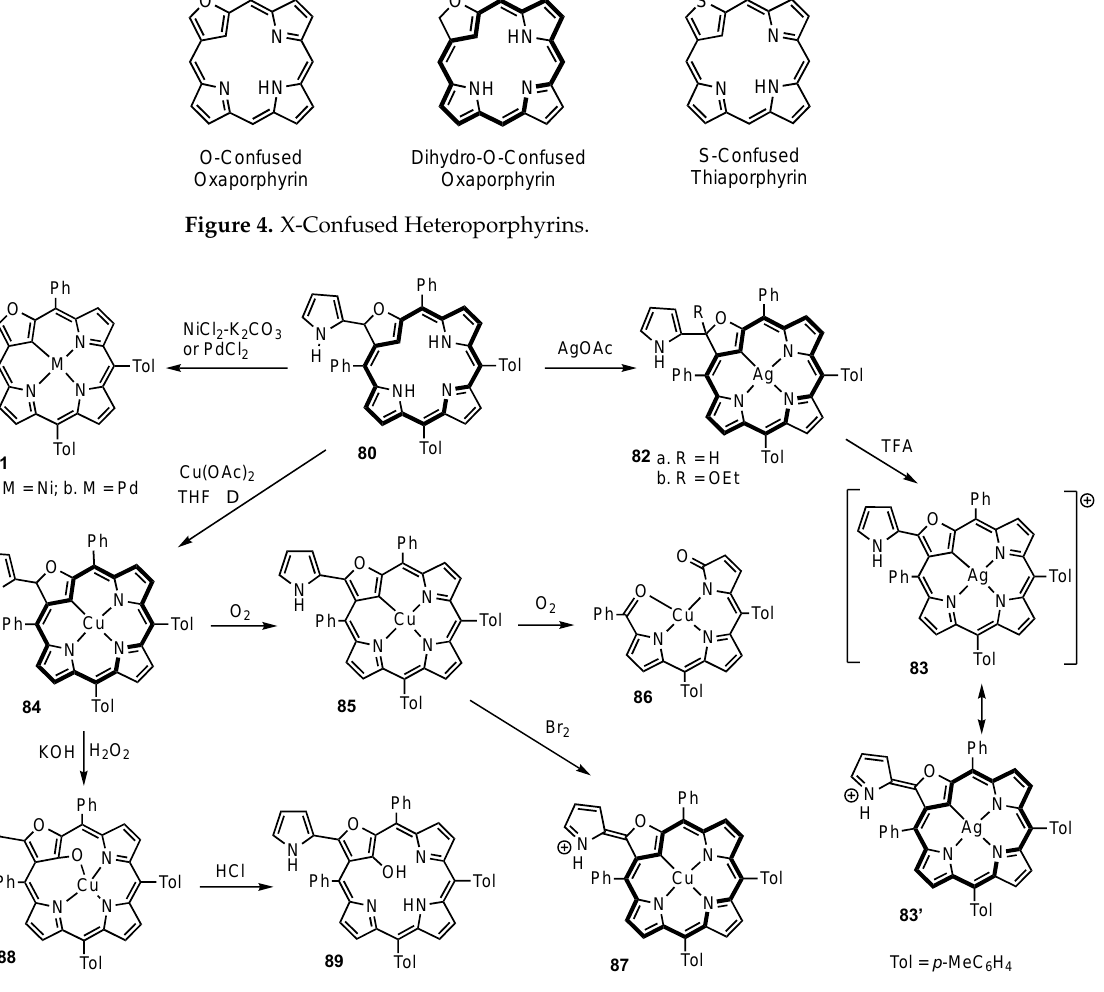
Scheme 19. Metal complexes of pyrrole-appended O-confused porphyrinoids.